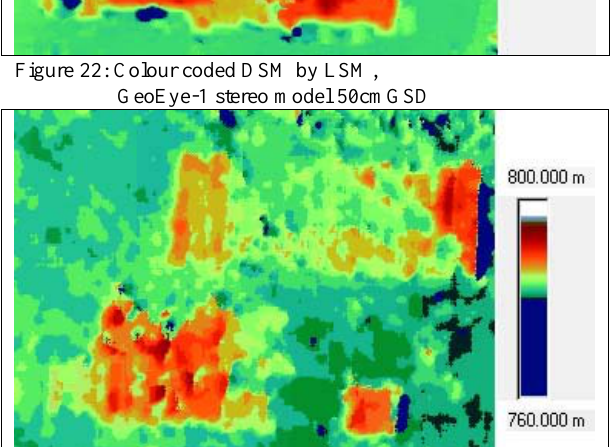
Figure 23: Colour coded DSM by SGM Aerial stereo model 63cm GSD